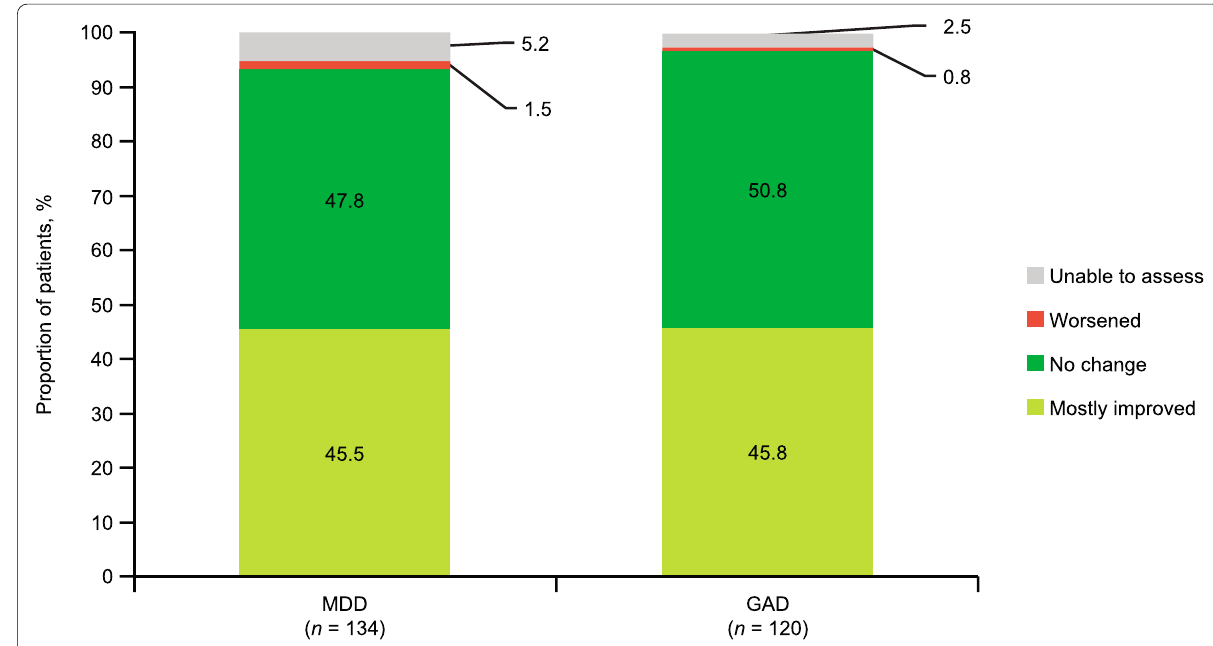
Fig. 3 Change in MDD and GAD severity. GAD, generalized anxiety disorder; MDD, major depressive